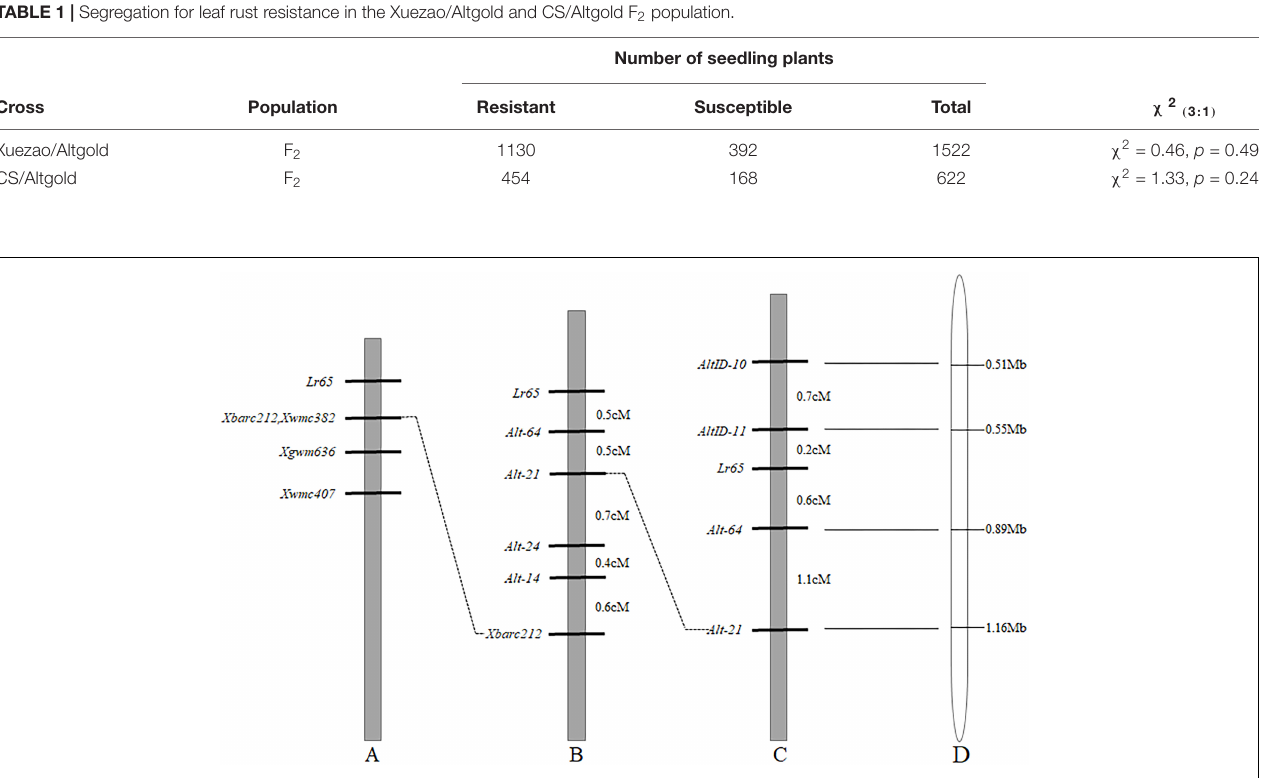
TABLE 1 | Segregation for leaf rust resistance in the Xuezao/Altgold and CS/Altgold F 2 population.